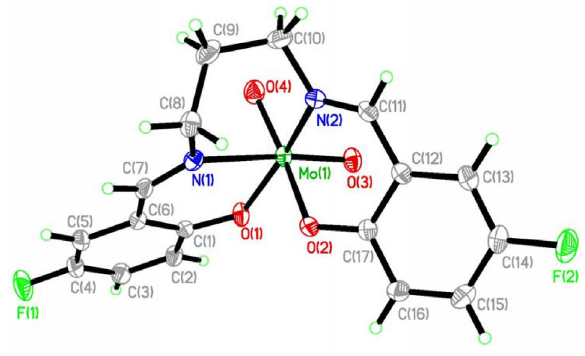
Fig. 1. Molecular structure of the molybdenum complex at 30% probability thermal